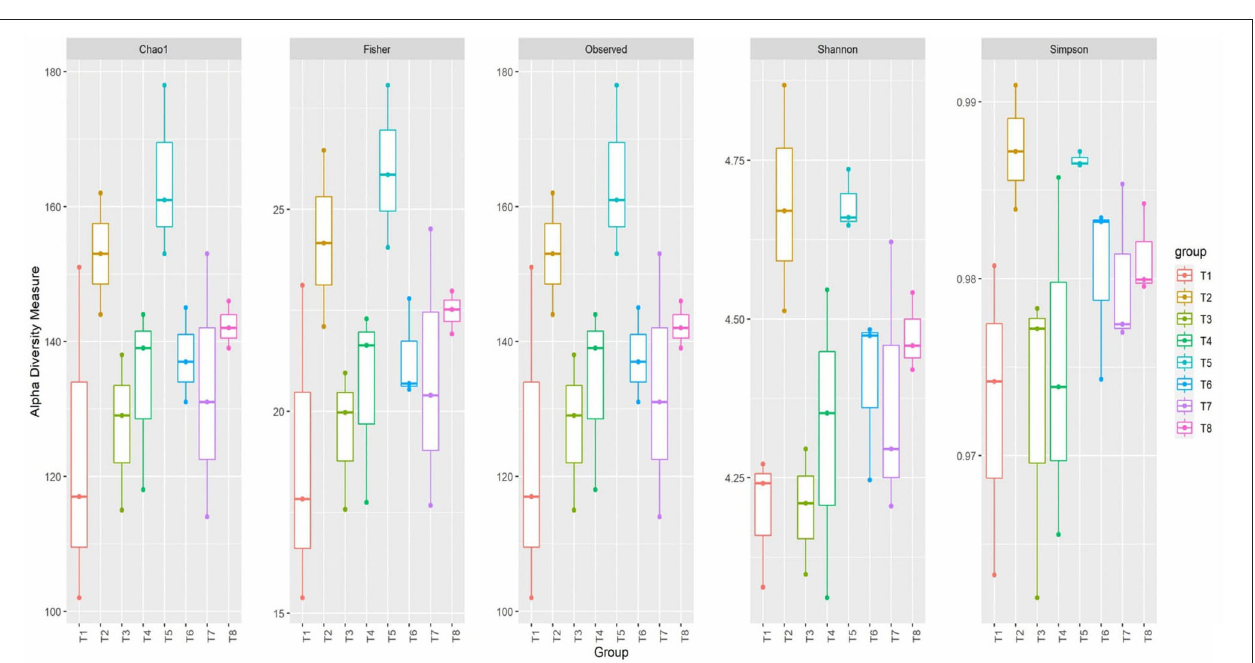
FIGURE 4 | Alpha diversity indices of colon mucosa microbiota of broiler chickens fed postbiotics and paraprobiotics. T1 = Negative control (Basal diet), T2 = Positive control [Basalt diet + 0.01% (w/w) Oxytetracycline], T3 = Basal diet + 0.2% (v/w) postbiotic TL1, T4 = Basal diet + 0.2% (v/w) Postbiotic RS5, T5 = Basal diet + 0.2%(v/w) paraprobiotic RG11, T6 = Basal diet + 0.2% (v/w) postbiotic RI11, T7 = Basal diet + 0.2% (v/w) paraprobiotic RG14, T8 = Basal diet + 0.2% (v/w) paraprobiotic RI11.